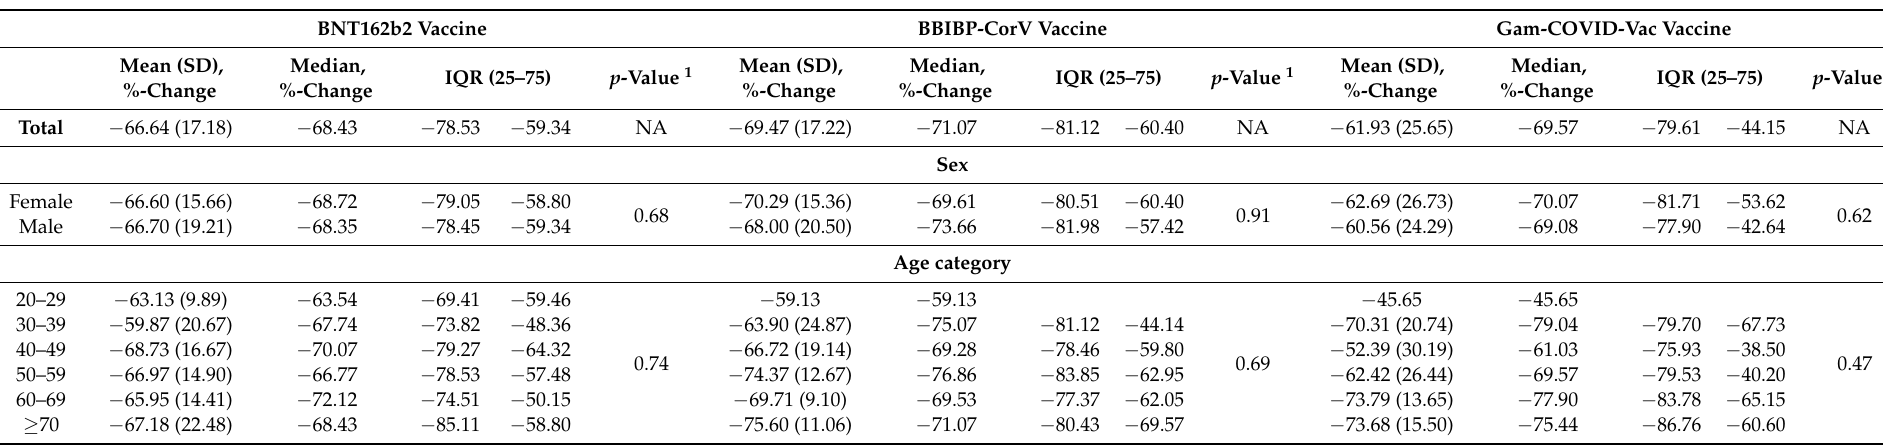
Table 2. Percentage change in Ab levels between the 28th day and at 6 months, stratified by sex and age groups of participants.